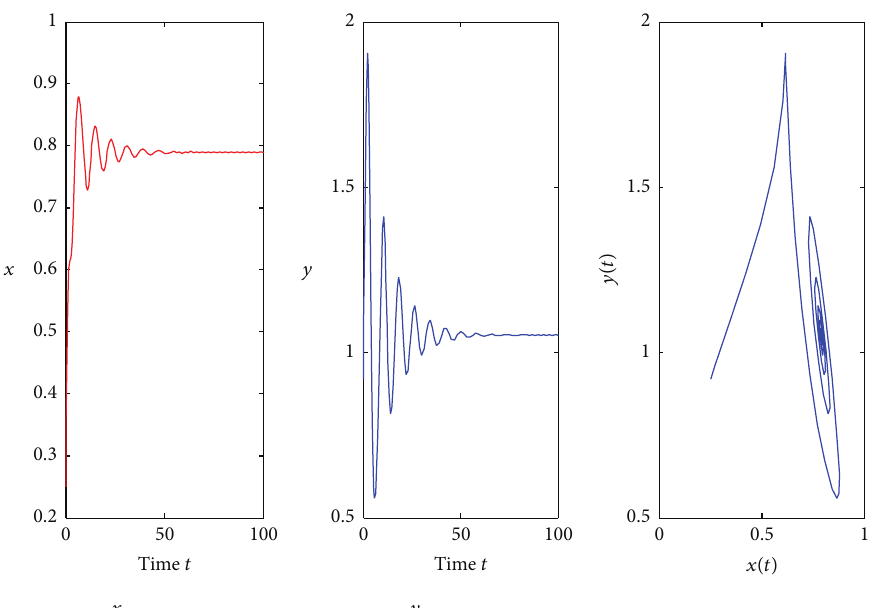
Figure 3: 𝐸 ∗ is asymptotically stable for 𝜏 2 = 1.65 < 𝜏 20 = 1.8631 with initial values “0.25;0.92.”